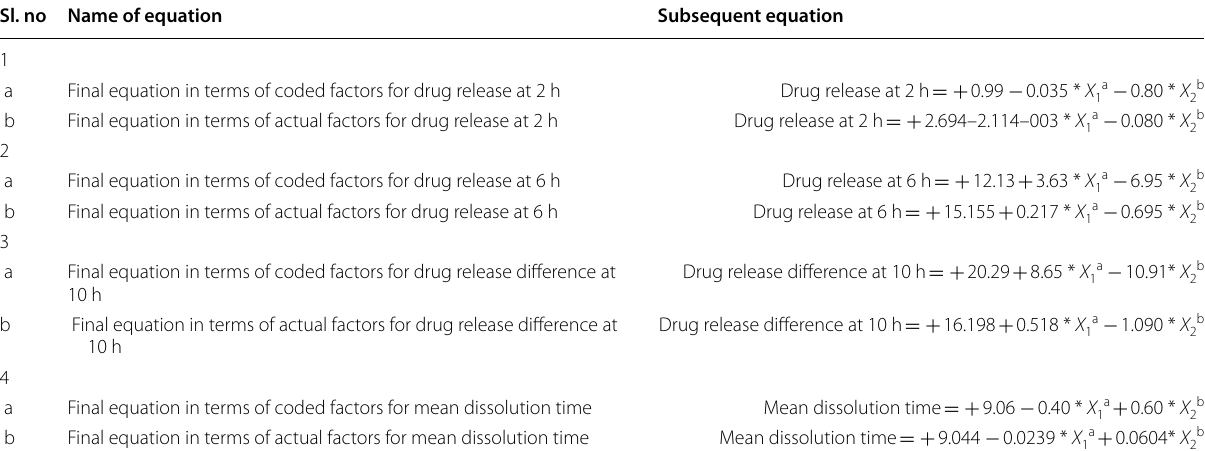
Table 4 Equations for optimization of response surface